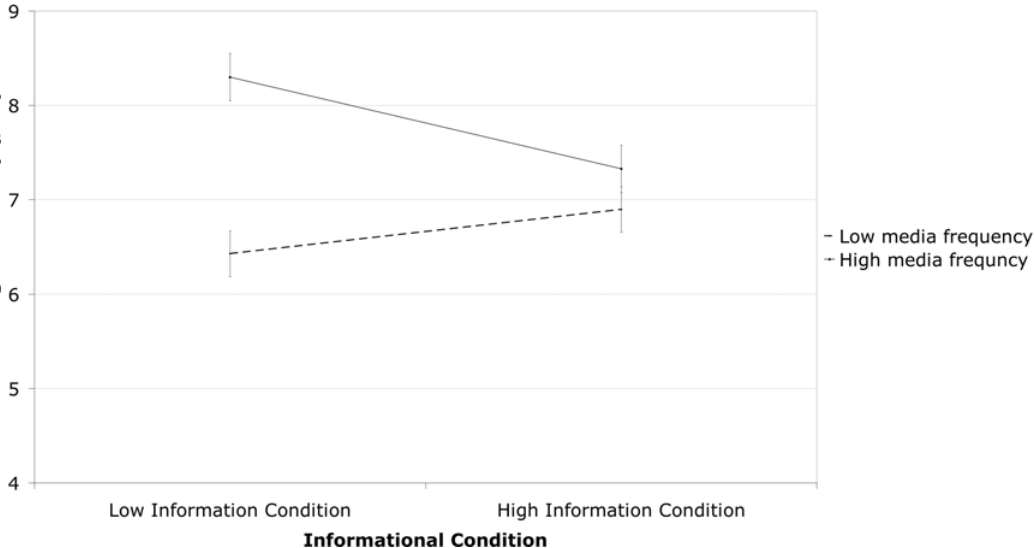
Figure 1. The interaction between Informational Conditions (high of low information) and Media Frequency (high or low) in estimations of severity made by undergraduate psychology participants. Error bars indicate Standard Error.